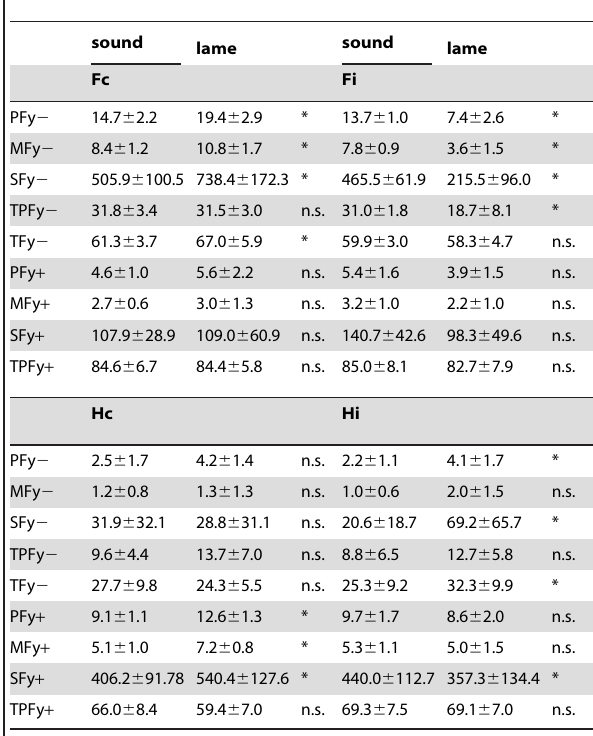
Table 1. Mean (M) and peak (P) as well as the sum (S) of the braking (Fy 2 ) and propulsive (Fy + ) forces in %BW for the sound condition and when lameness was induced in the right forelimb (Fi) in the walking Beagles.